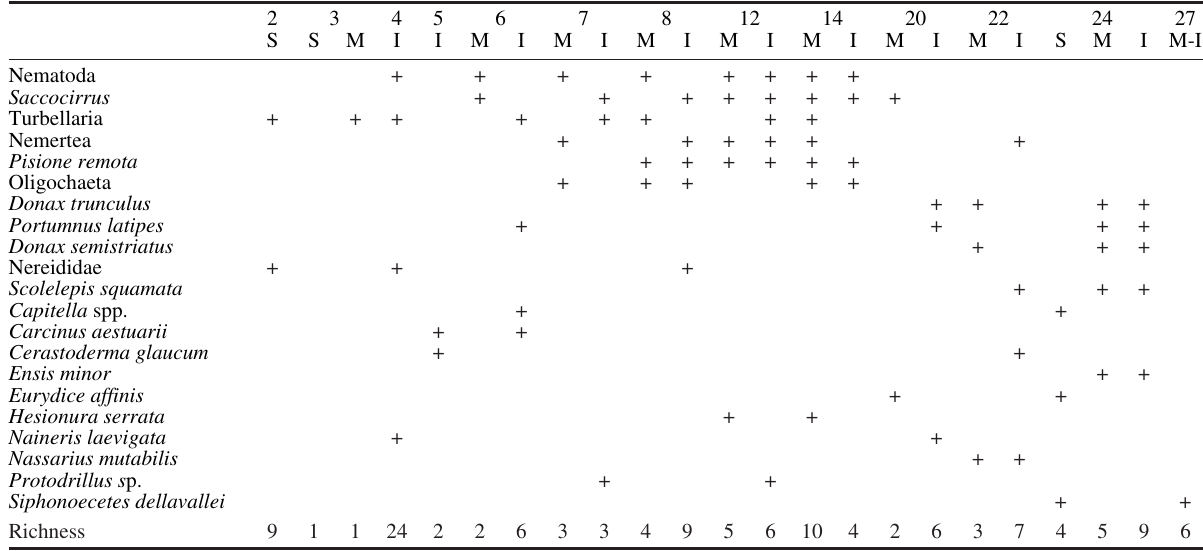
Table 6. – Main taxa collected through the qualitative sampling at the supralittoral (S), mediolittoral (M) and infralittoral (I) levels. Taxa are ordered by their total frequency throughout sites. Only taxa found at more than one site are shown. For the site numbers see Tables 1 and 2.